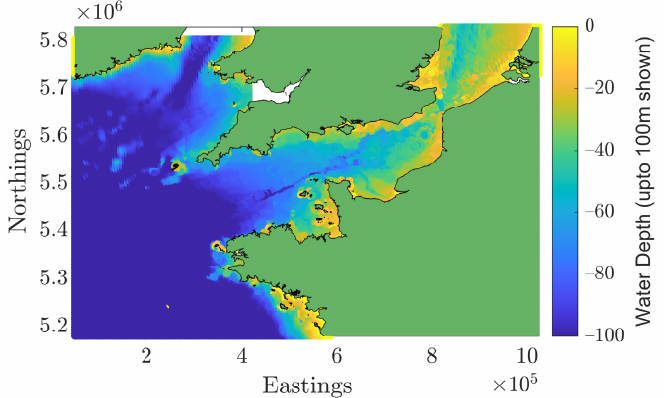
Figure 2. Seabed bathymetry across the domain using in the models.